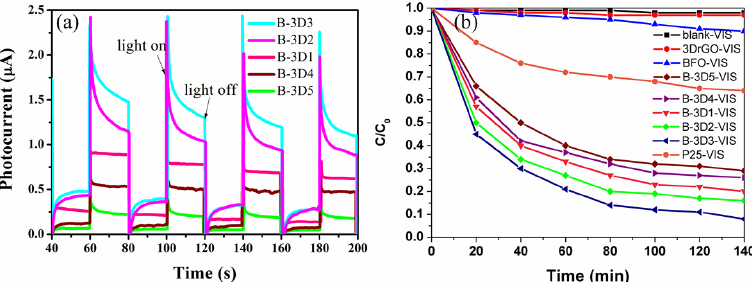
Figure 6. UV—vis absorption spectra ( a ) and corresponding ( α hv ) 2— hv curves ( b ) of 3D BFO/graphene composites. Table 1. The band gaps of 3D BFO/graphene composites.